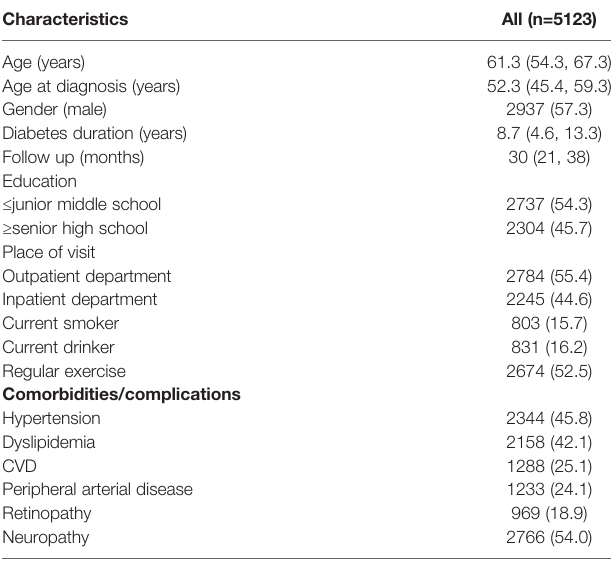
TABLE 1 | Characteristics of the overall study